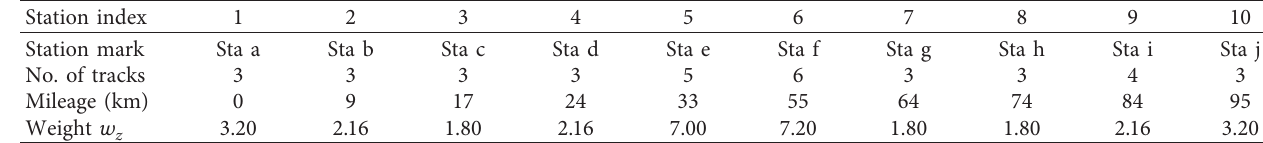
Table 1: Information about each station.